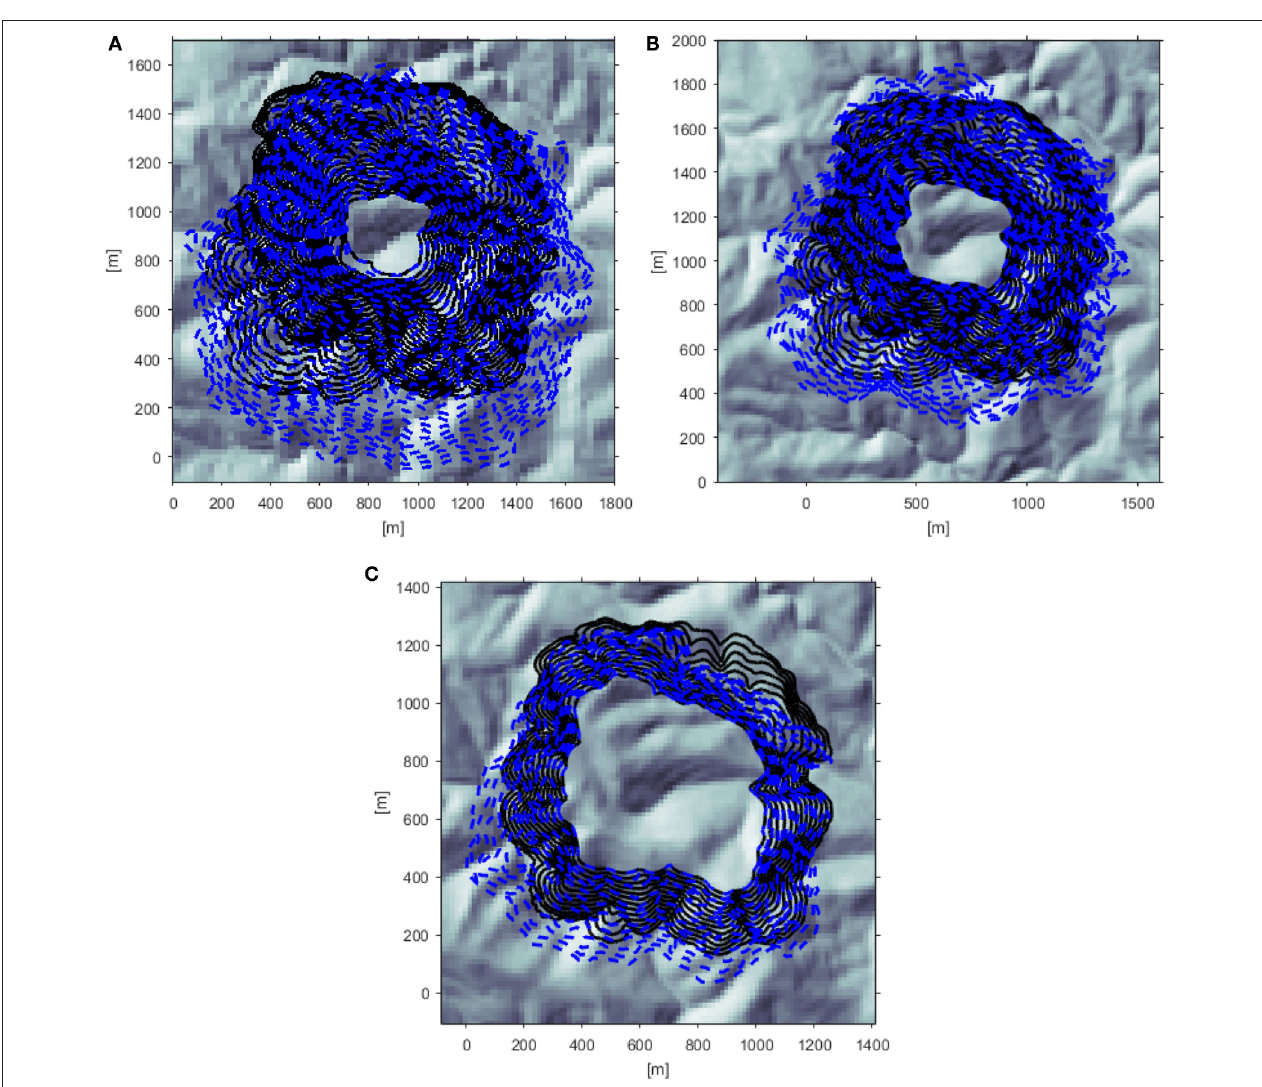
FIGURE 8 | Forecast run (blue dashed lines) vs. observations (black solid lines) for the three cases. (A) 5 assimilated fronts, 29 forecast fronts. (B) 10 assimilated fronts, 24 forecast fronts. (C) 22 assimilated fronts, 12 forecast fronts.